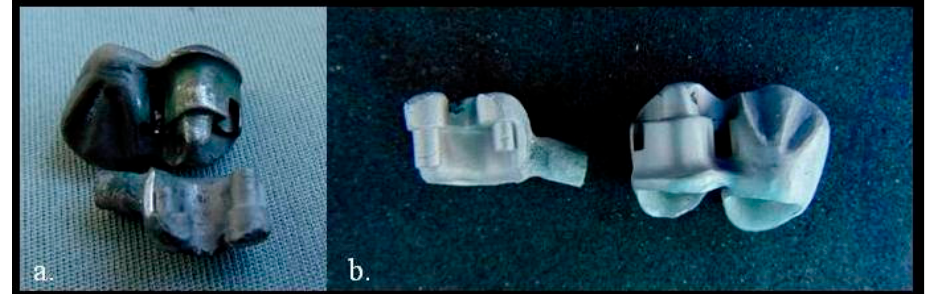
Figure 12. ( a ) Separation of the Pb + and Pa framework, after detachment from the mold; ( b ) assembly surfaces, after sandblasting.